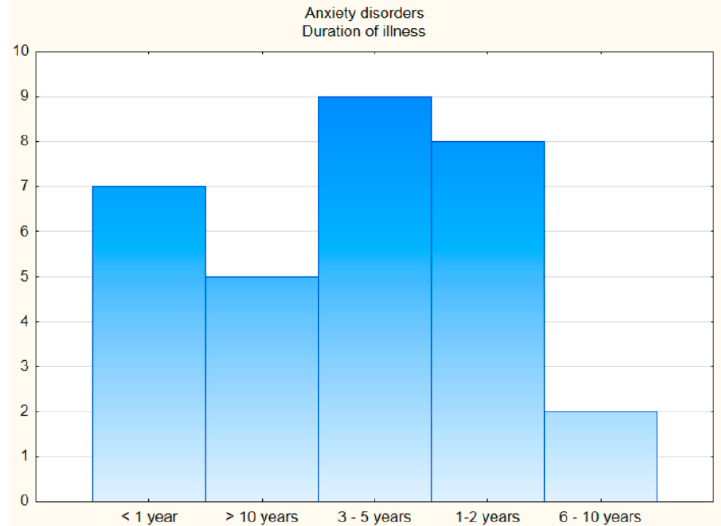
Figure 1. The duration of illness.